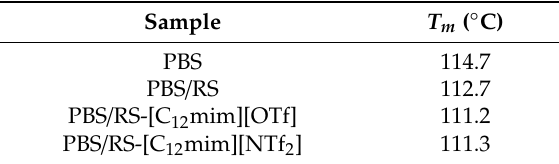
Figure 4. DSC thermograms of the PBS and PBS/RS blends without and with containing ILbS. Table 5. T m of the PBS and PBS / RS blends without and with containing ILbS as obtained from DSC